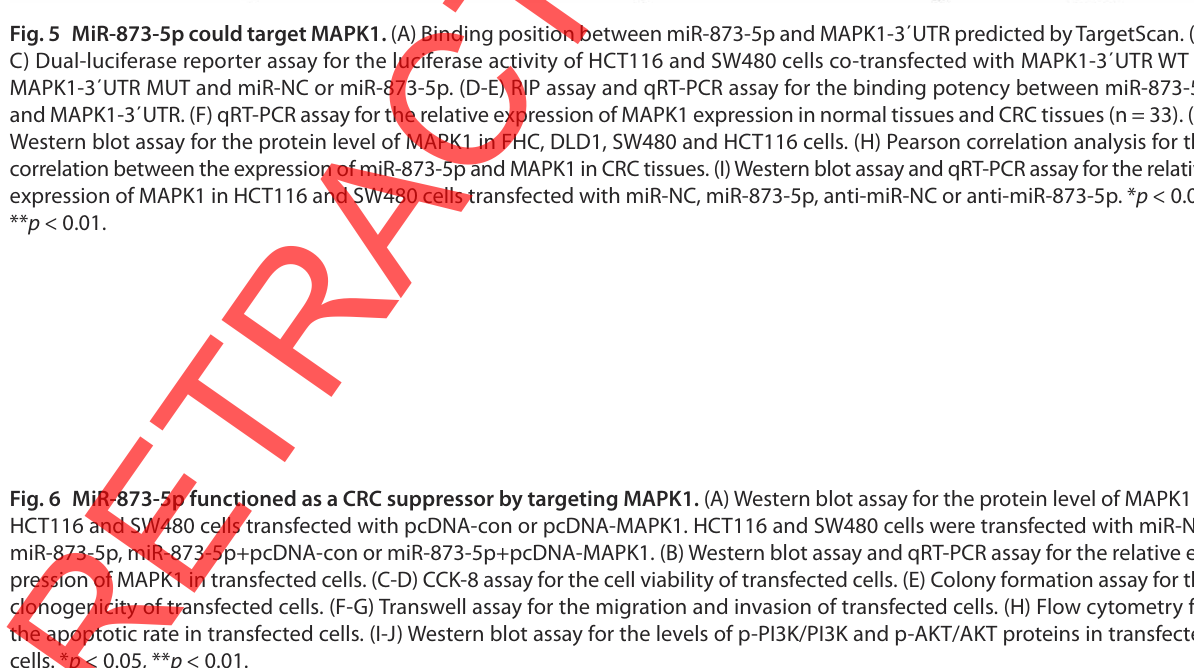
Fig. 6 MiR-873-5p functioned as a CRC suppressor by targeting MAPK1. (A) Western blot assay for the protein level of MAPK1 in HCT116 and SW480 cells transfected with pcDNA-con or pcDNA-MAPK1. HCT116 and SW480 cells were transfected with miR-NC, miR-873-5p, miR-873-5p+pcDNA-con or miR-873-5p+pcDNA-MAPK1. (B) Western blot assay and qRT-PCR assay for the relative ex- pression of MAPK1 in transfected cells. (C-D) CCK-8 assay for the cell viability of transfected cells. (E) Colony formation assay for the clonogenicity of transfected cells. (F-G) Transwell assay for the migration and invasion of transfected cells. (H) Flow cytometry for the apoptotic rate in transfected cells. (I-J) Western blot assay for the levels of p-PI3K/PI3K and p-AKT/AKT proteins in transfected cells. * p < 0.05, ** p < 0.01.